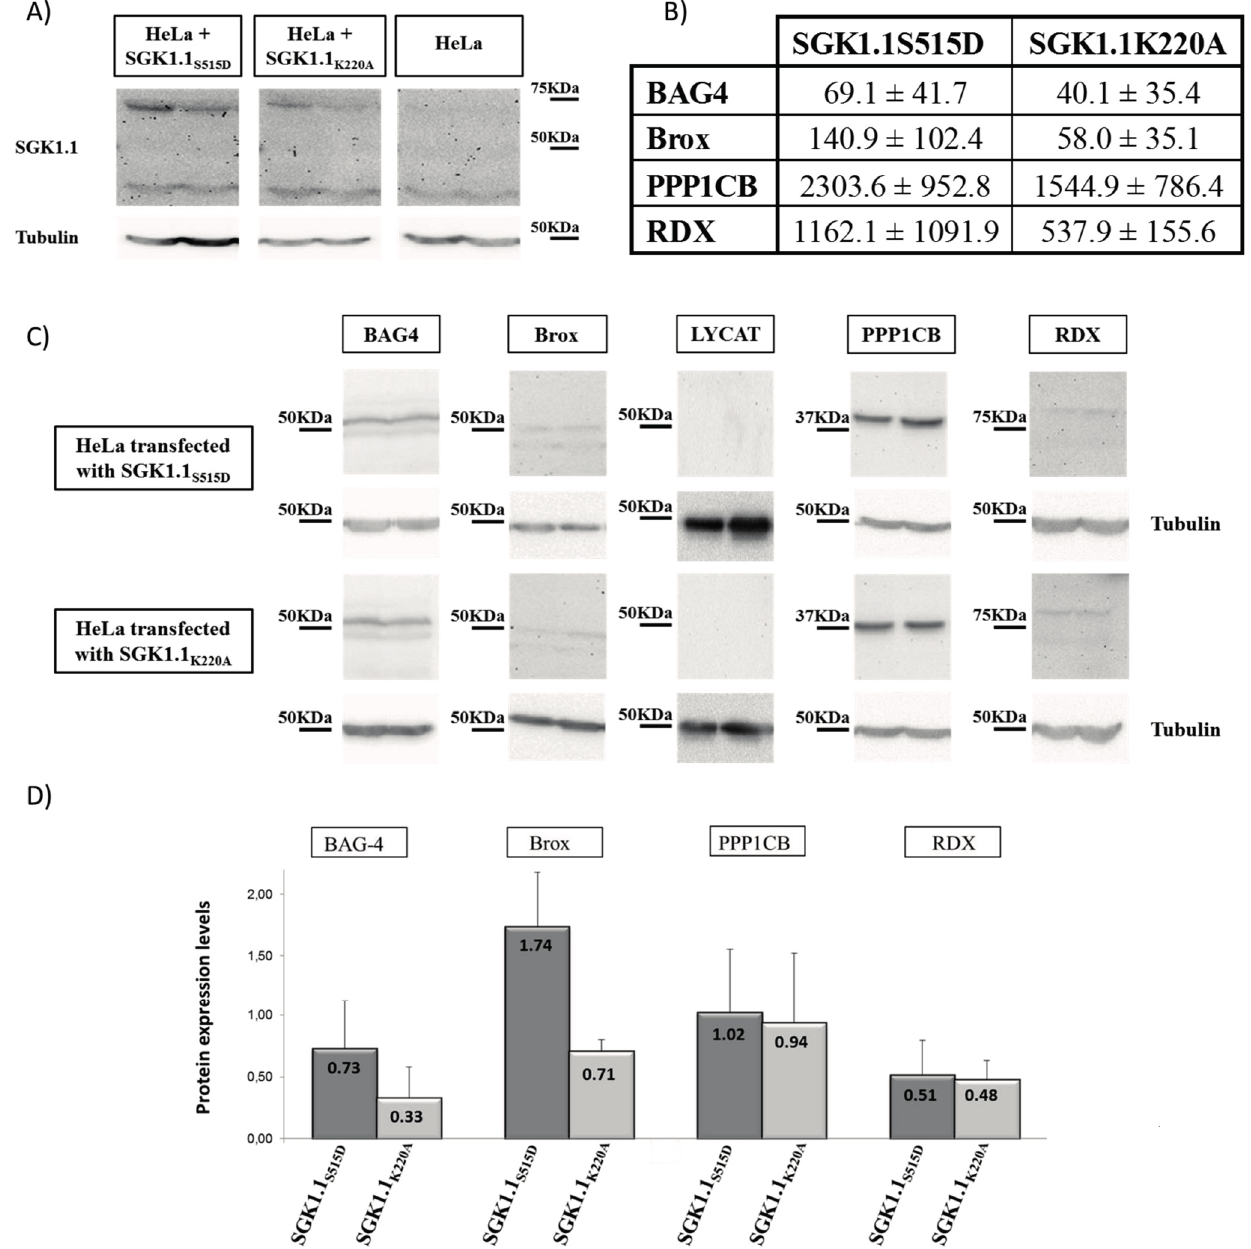
Figure 2. Western blots ( A , C ), quantification of mRNA relative expression ( B ) and bar chart of protein expression ( D ) of BAG-4, Brox, LYCAT, PPP1CB and RDX of same eight HeLa cultures of transfected cells used for ( D ) data. ( A ) Examples of SGK1.1 expression in transfected and no transfected HeLa cells and tubulin reference; ( B ) Mean ± standard deviation for BAG-4 , Brox , PPP1CB and RDX gene expression as ×10 5 relative to β -actin; ( C ) Examples of quantitated proteins and tubulin reference; ( D ) BAG-4, Brox, PPP1CB and RDX proteins expression levels relative to β -tubulin shown as mean ± standard